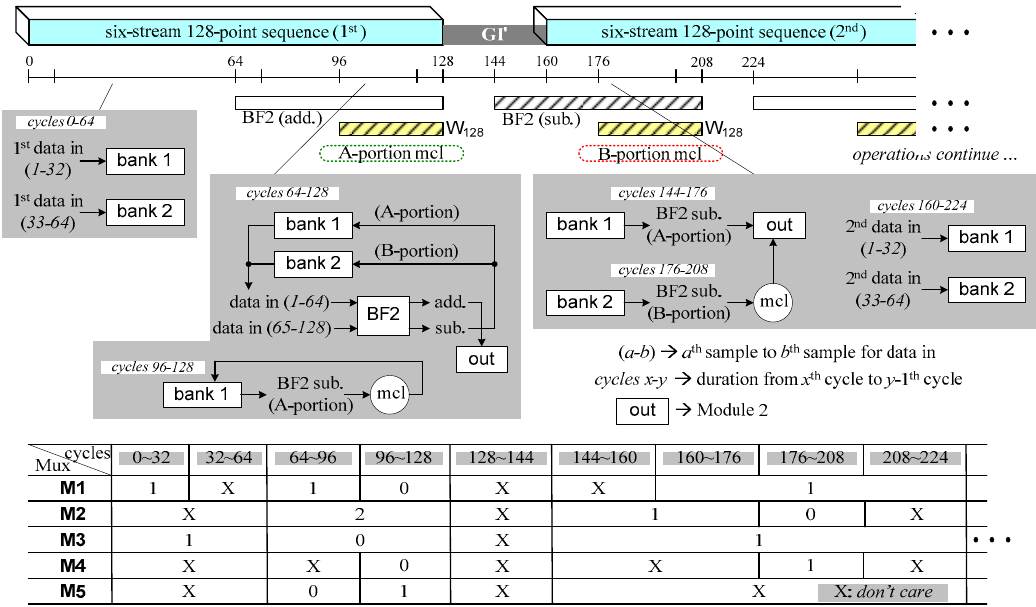
Figure 10. Detailed operations of Module 1 and control of multiplexers (M1–M5) based on clock cycles.